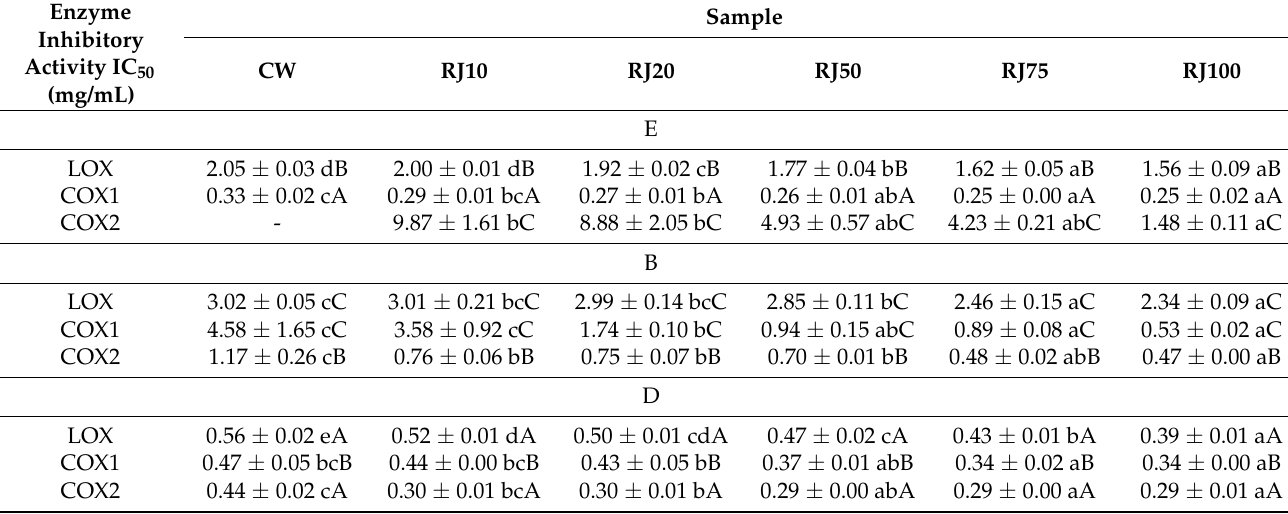
Table 5. Lipoxygenase (LOX) and cyclooxygenase 1 and 2 (COX1, COX2) inhibitory activity of extracts from the control and fortified